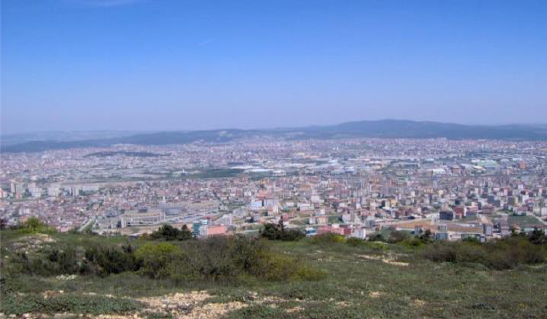
Figure 5. Settlement Area of Elmalı Basin (Geymen, 2016) Table 1. the land use cases for 2013, 2015, 2018 and 2020 are